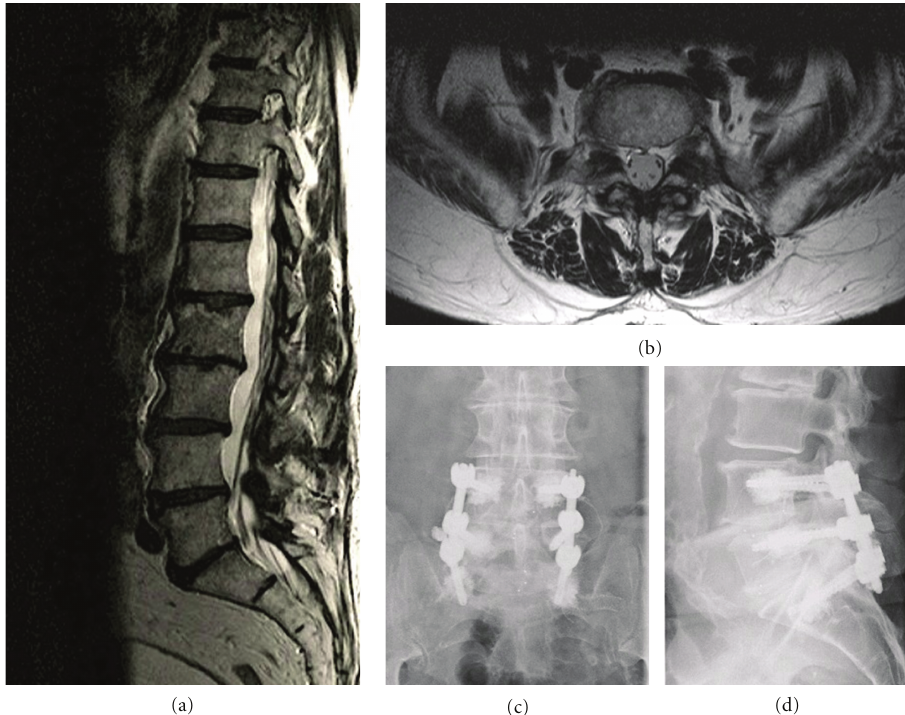
Figure 8: Illustrative Case number 9. Radiological studies obtained in a 83-year-old man. Sagittal (a) and axial (b) T2-weighted magnetic resonance images of the lumbar spine, showing narrowing of the spinal canal at L4–5 and L5-S1 and bilateral foraminal stenosis. (c and d): AP and lateral radiograph at 12 months postoperative demonstrating the proper position of the screws and cages, and the absence of implant-related complication.